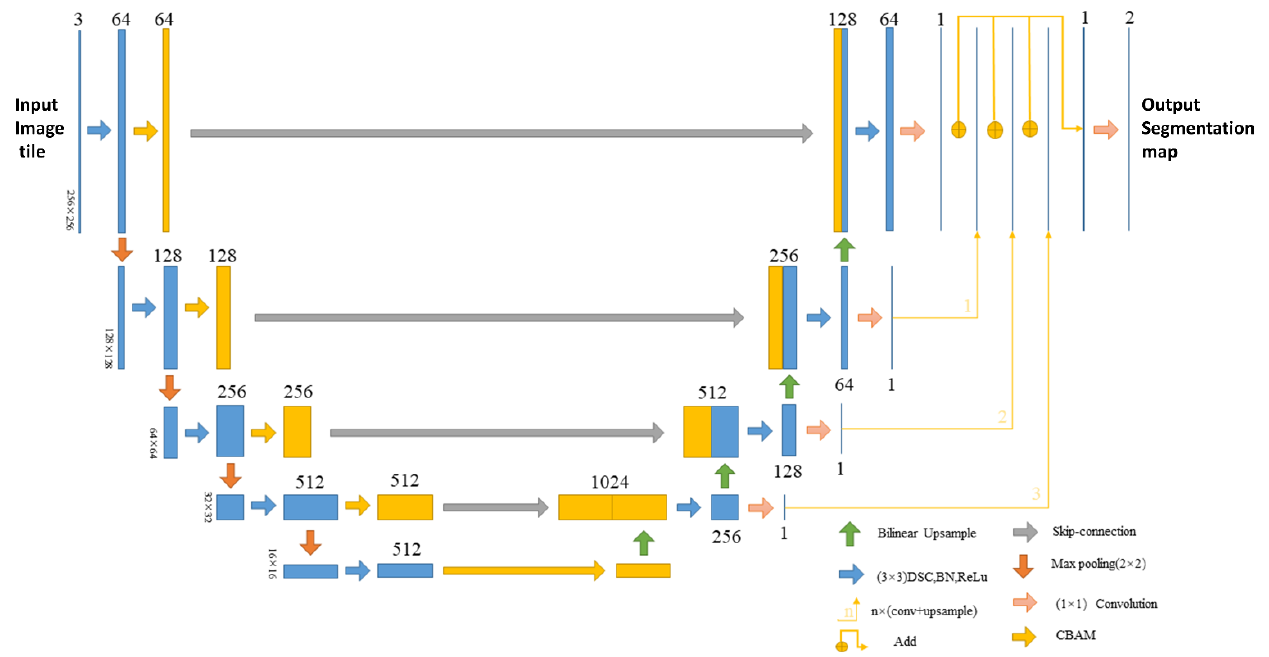
Figure 6. SAH-Unet model architecture. Each box corresponds to a multi-channel feature map. The number of channels is denoted at the top of the box. The size is provided at the lower left edge of the box. The arrows denote the different operations.